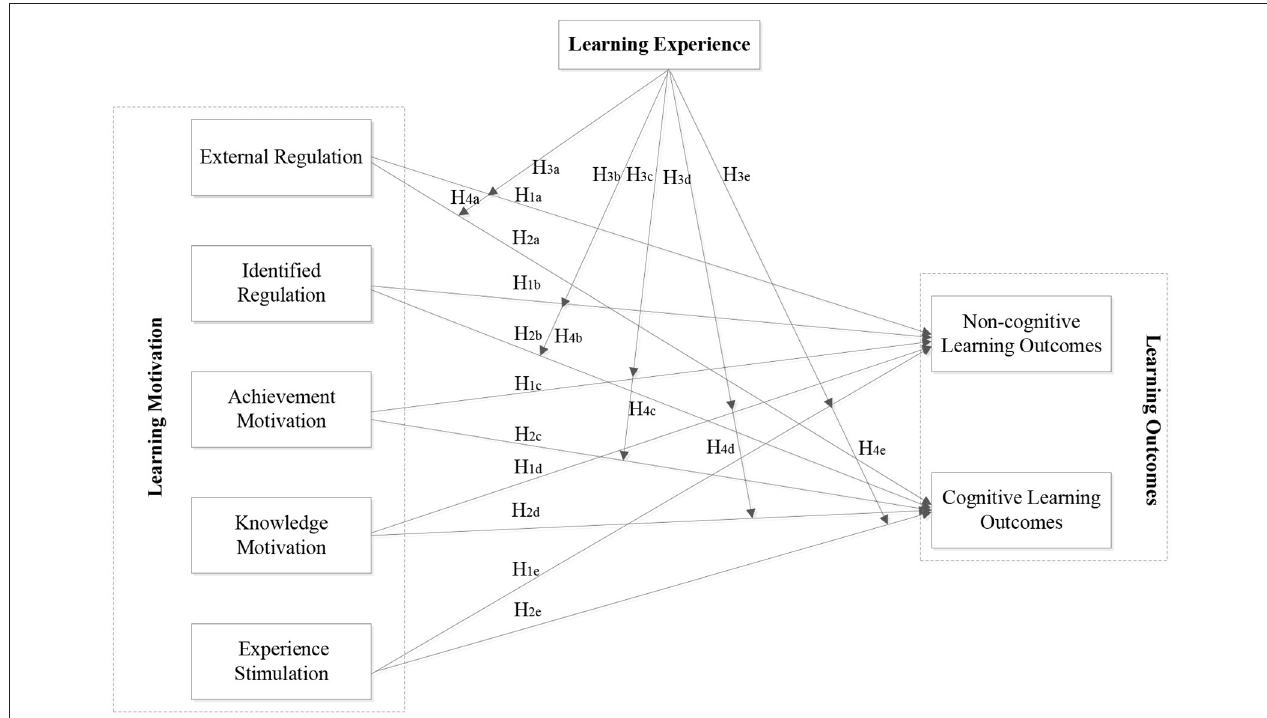
FIGURE 1 | Model describing the (hypothesized) moderating influence of learning experience between learning motivation and learning outcomes.